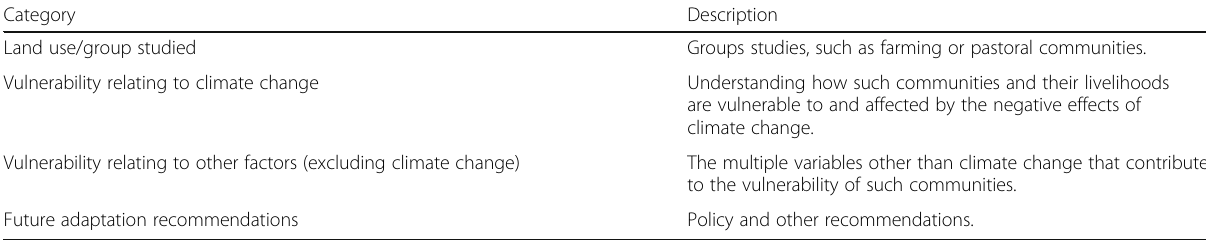
Table 6 Classification of articles in to four selected categories for the climate adaptation literature Category